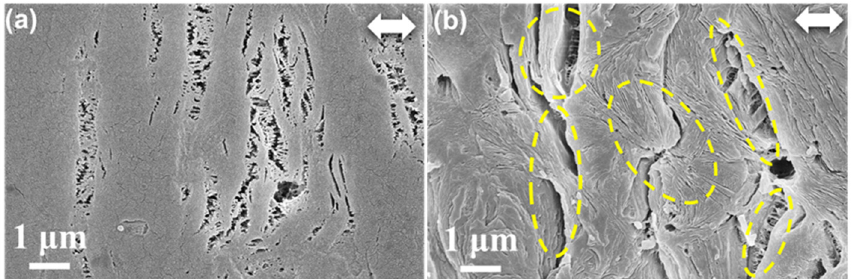
Figure 3. ( a ) SEM image of β -PP stretched to 20% at 100 °C. ( b ) SEM image of β -PP stretched to 20% at 100 °C, followed by etching away of the amorphous region. The white double arrow represents the direction of stretching.